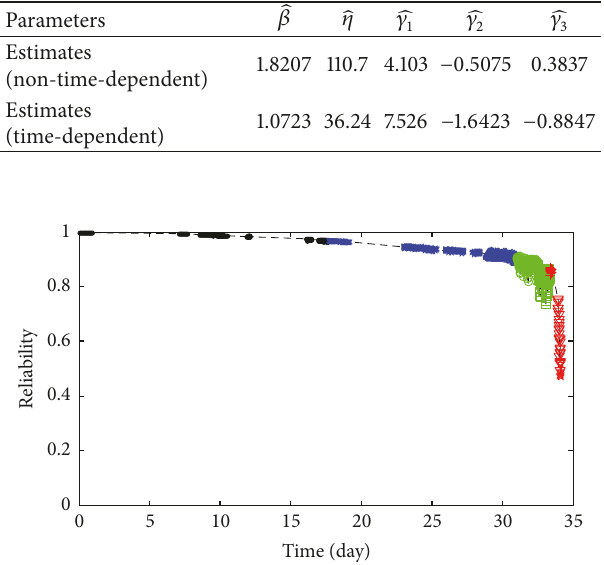
Figure 9: Lifetime reliability (non-time-dependent covariates).